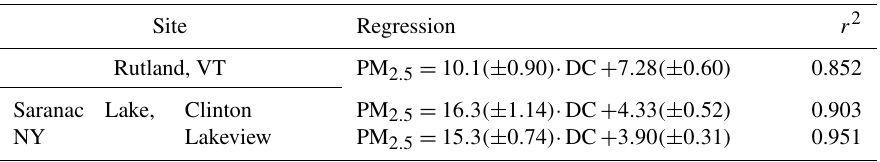
Table 4. Semi-quantitative relationship between DC (µgm − 3 ) and PM 2 . 5 (µgm − 3 ) in woodsmoke-dominated ambient environments. The values inside the parentheses represent the corresponding one standard